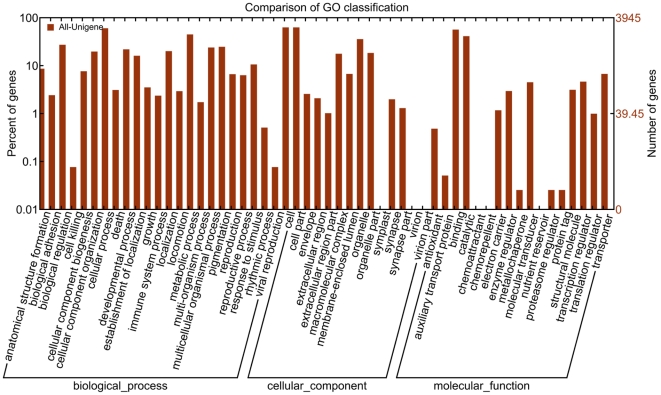
GO categories of the unigenes.Unigenes were annotated in three main categories: biological process, cellular component and molecular function.